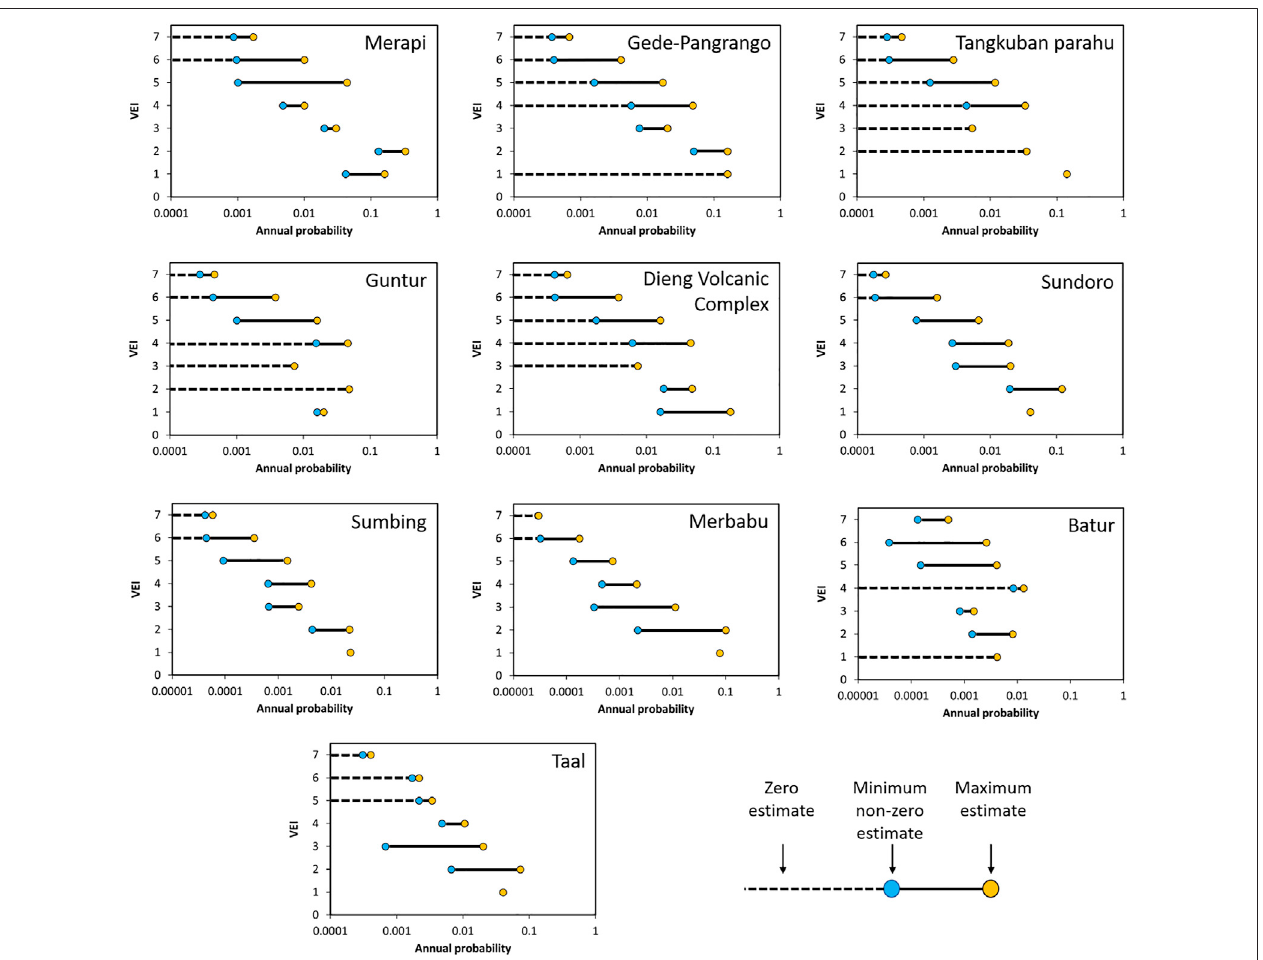
FIGURE5| MaximumandminimumpublishedannualprobabilitiesofeachVEIforvolcanoeswithatleasttwodifferentpublishedestimates.Note:notall x -axesare the same